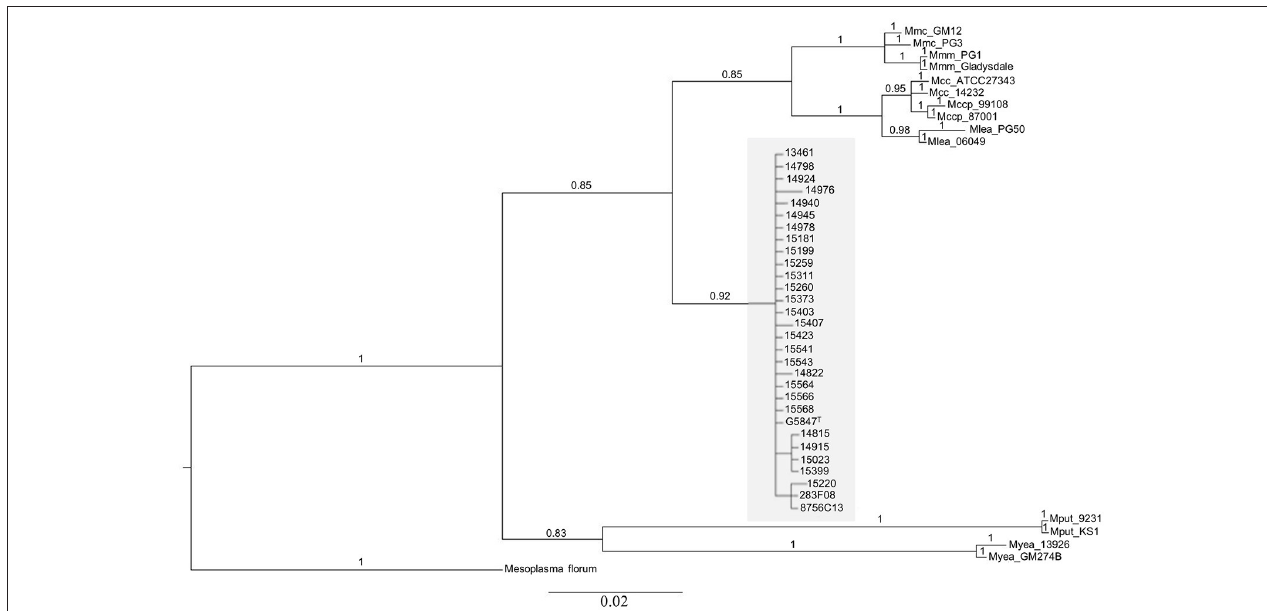
FIGURE 1 | Phylogenetic relationships of mycoplasma isolates, of which 28 represent the new species M. feriruminatoris , based on Bayesian analysis of 187 amino-acids alignment of the fusA protein. The statistical supports indicated above branches correspond to Bayesian posterior probabilities. The scale bar below the tree shows the average number of substitutions per site. M. feriruminatoris isolates are shown in a gray box.